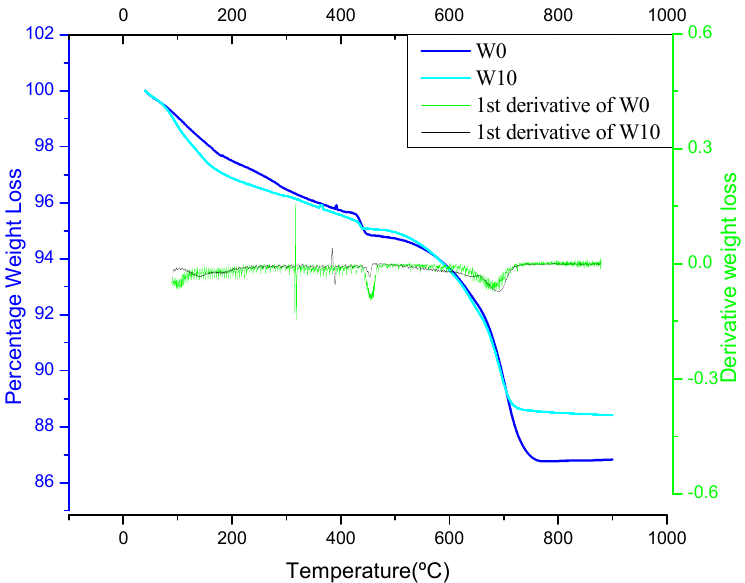
Figure 17. Thermogravimetric analysis and derivative weight loss curves of W0 and W10 mixes.